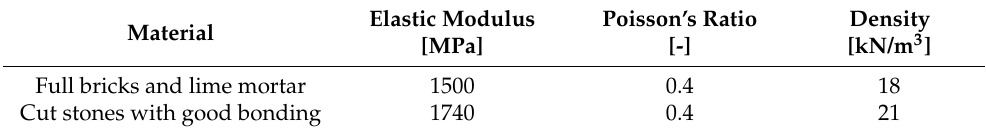
Table 2. Materials parameters used for the starting FE